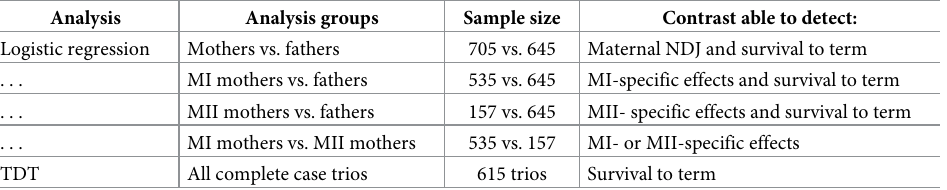
Table 1. Description of primary analyses and associated sample sizes.